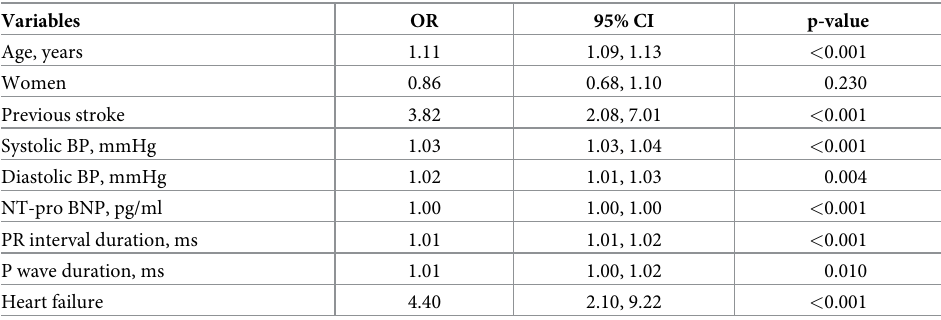
Table 2. Prediction of advanced WMHs (Fazekas stage 2–3), univariable (unadjusted) analysis. Variables